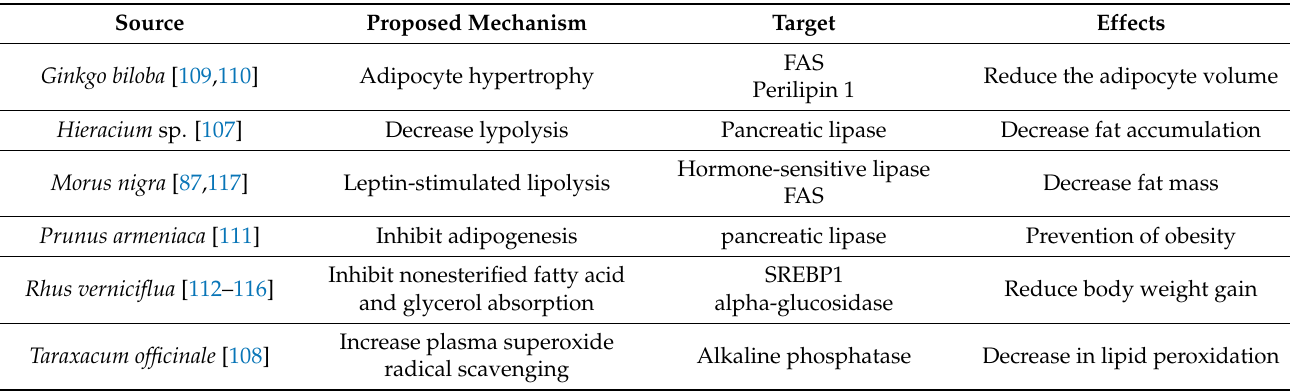
Table 10. Herbal extracts inhibiting lipase